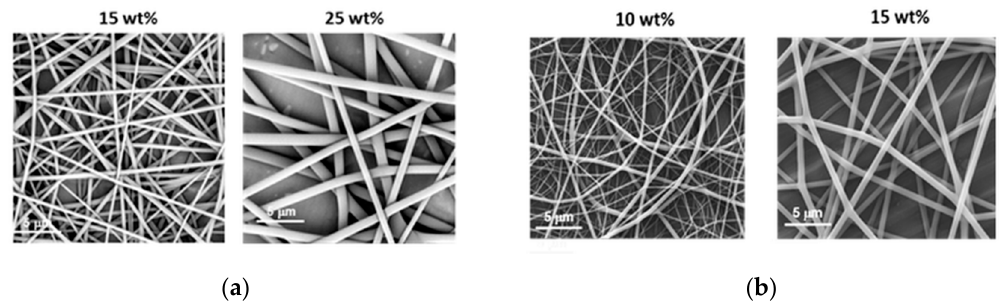
Figure 3. Morphology of ( a ) PiPrOx 21k and ( b ) PiPrOx 42k fibres obtained at different concentrations in HFP (flow rate of 1 mL/h).